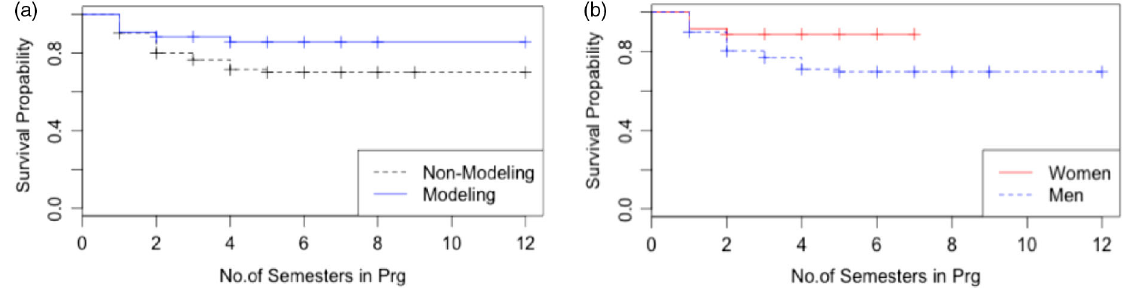
FIG. 3. Survival towards graduation for majors. These survival curves indicate the probability of persisting in the major and graduating with a physics degree. In (a) modeling students and traditional students have the same statistical likelihood of persisting towards graduation. (b) Women are statistically more likely to persist towards graduation than men by their 5th semester in upper level